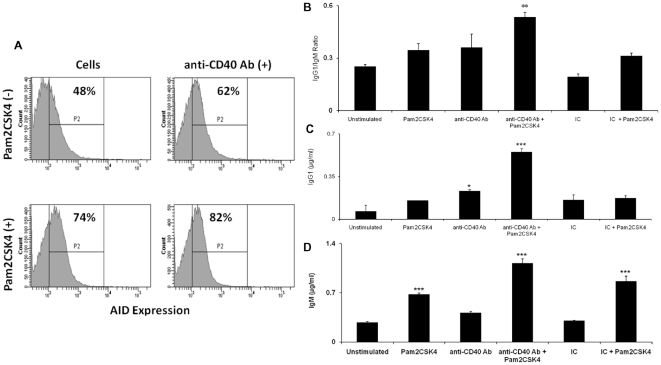
CD40 costimulation of TLR-2 elicited RB cells augments the expression of AID, class switch recombination and IgG1/IgM secretion.Signaling through TLR-2 and CD40 was delivered with Pam2CSK4 and anti-CD40 Ab respectively in RB cells. (A) Cells were stained for expression of intracellular AID after 48 h of stimulation and data were analysed by flowcytometry. Values represent the percentage of cells expressing AID. Histograms are representative of three different experiments. (B) Ratio of IgG1/IgM (index of CSR) was calculated on the basis of their surface expression after 48 h of stimulation. Data are pooled from three independent experiments and expressed as mean ± SD. (C) Secretion of IgM and IgG1 was estimated by sandwich ELISA in the culture SNs after stimulating cells for 7 d. Data are expressed as mean ± SEM from 2–3 independent experiments. ‘*’, ‘**’, ‘***’ indicates p<0.05, p<0.01, p<0.001 respectively.